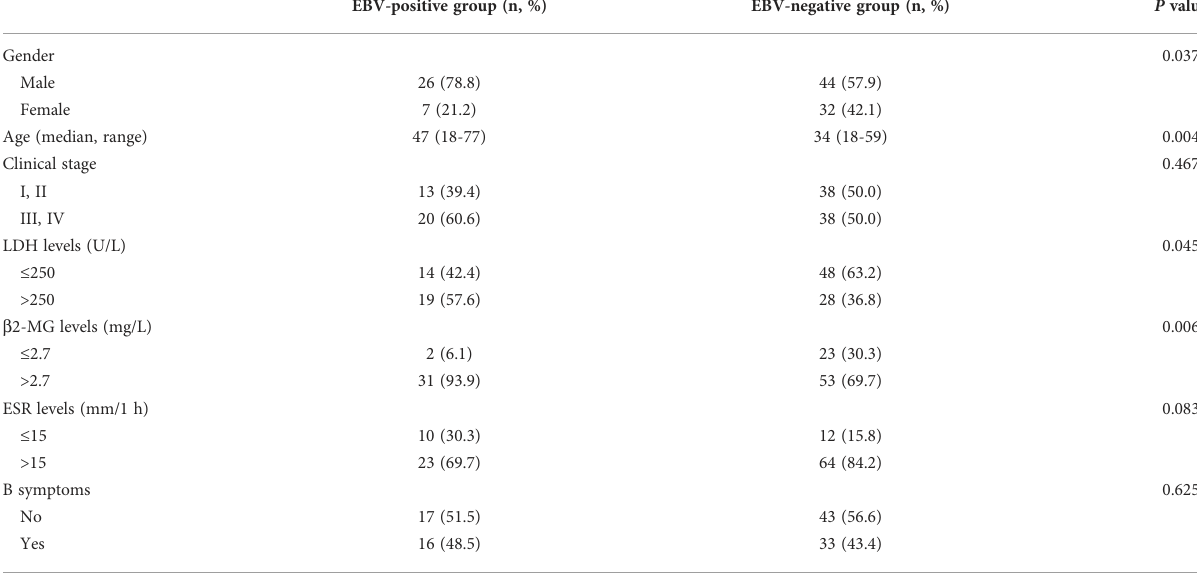
TABLE 1 Clinical information of nodular sclerosis classical Hodgkin lymphoma in this cohort. EBV-positive group (n,